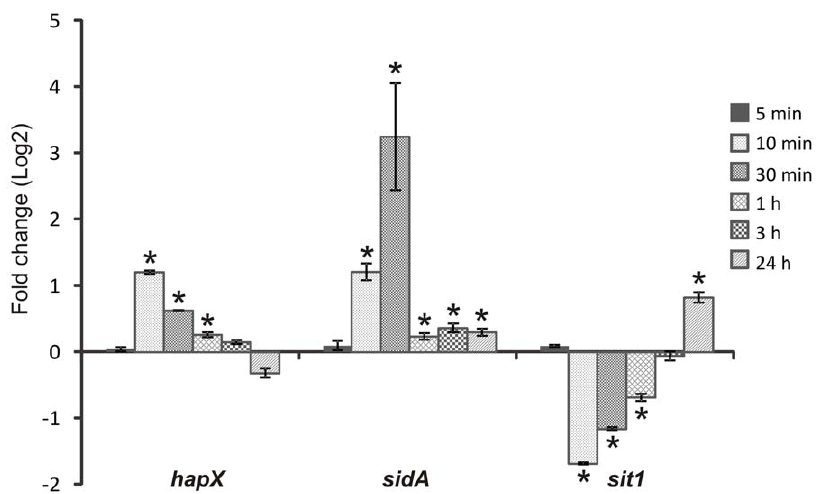
Figure 2. Induction of P.brasiliensis iron acquisition genes following iron restriction. Quantitative RT-PCR determined P. brasiliensis transcript levels of hapX , sidA and sit1 during iron deprivation. Data were normalized to the L34 protein transcript. Student’s t test was used for statistical comparisons. Error bars represent standard deviation from three biological replicates while * represents p # 0.05.